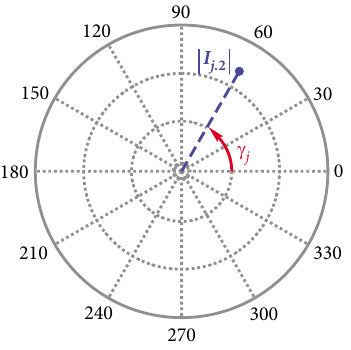
Fig. 21. Variables (cid:95) I